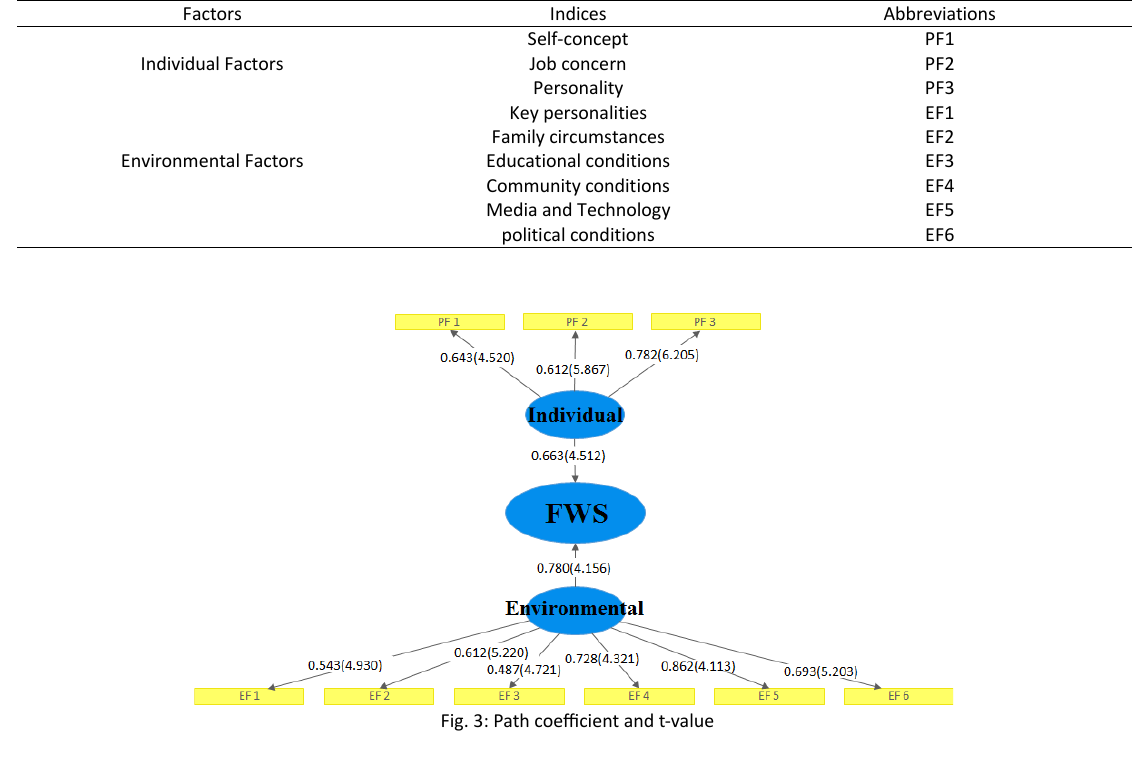
Table 6: Guide to Identifying the Abbreviations of Model Variables